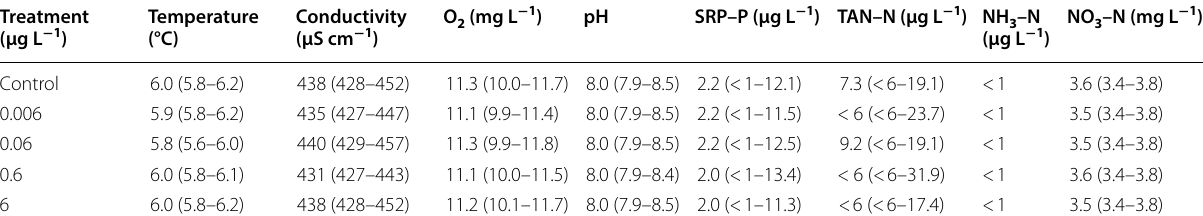
Table 3 Median (minimum–maximum) of the physical and chemical parameters determined in the different treatments during the terbutryn experiment